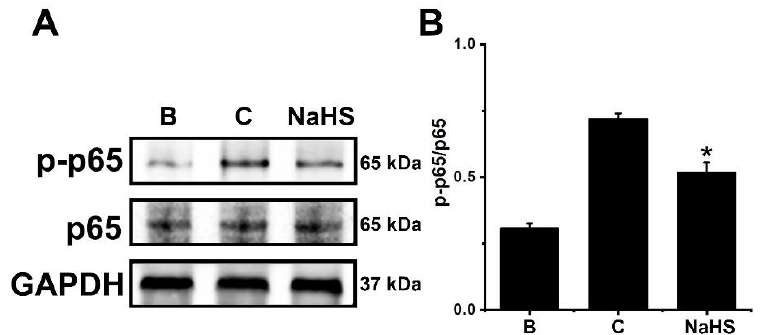
Figure 5. Inhibition of NF- κ B phosphorylation by NaHS in dHL-60 cells. ( A ) Cells (5 × 10 6 /mL) were pretreated with NaHS (1 mM) for 1 h, followed by GM-CSF-stimulation (5 ng/mL) for 30 min. ( B ) The protein levels were quantitated by densitometry. Blank (B) corresponds to PBS treated cells without GM-CSF stimulation, and control (C) corresponds to PBS treated cells stimulated by GM-CSF. Results are expressed as the mean ± SEM from three separate experiments. * p < 0.05, as compared with the PBS treated cells stimulated by